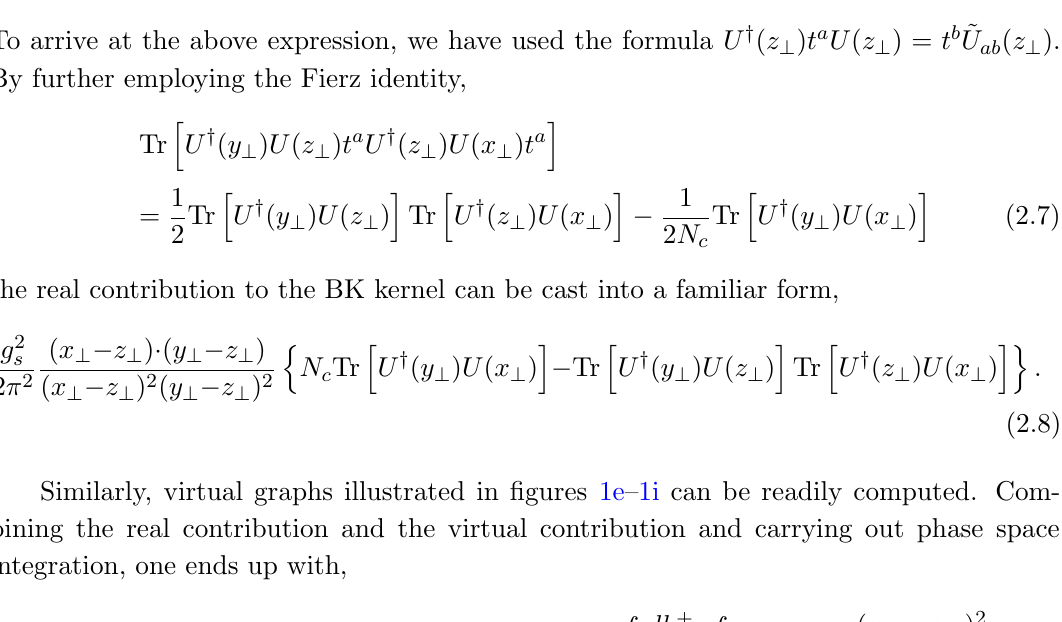
Figure 1 . Real and virtual diagrams which contribute to the BK kernel at the leading order. The black dot stands for multiple gluon re-scattering. The straight solid line represents the Wilson line in the fundamental